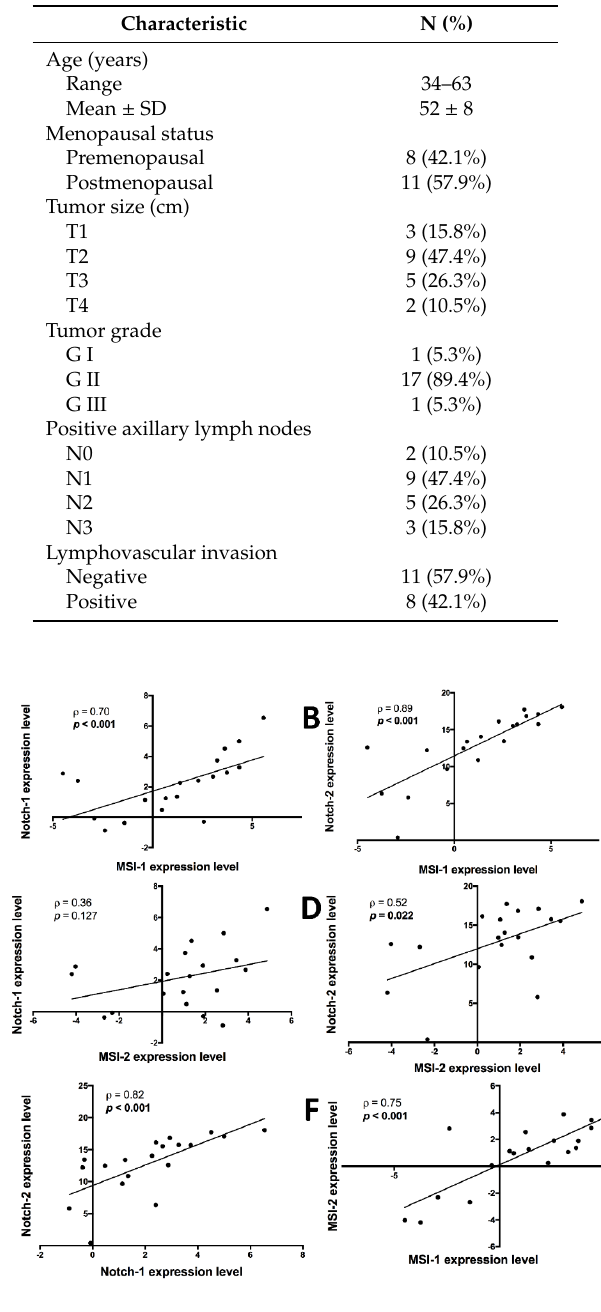
Figure 1. Correlations between mRNAs of Notch-1 , Notch-2 , Musashi-1 ( MSI-1 ) and Musashi-2 ( MSI-2 ), as measured by quantitative polymerase chain reaction (qPCR) in 19 triple-negative breast cancer patient samples. After normalization to the housekeeping gene, respective gene expression was evaluated using the 2 − ∆∆ Ct method with data then presented as log2-transformed fold change. Spearman’s ρ and respective p value (in bold if p < 0.05) are given for each correlation. A : MSI-1 expression is positively correlated with Notch-1 expression. B : MSI-1 expression is positively correlated with Notch-2 expression. C : MSI-2 expression is not significantly correlated with Notch-1 expression, though trending towards a positive correlation. D : MSI-2 expression is positively correlated with Notch-2 expression. E : Notch-1 expression is positively correlated with Notch-2 expression. F : MSI-1 expression is positively correlated with MSI-2